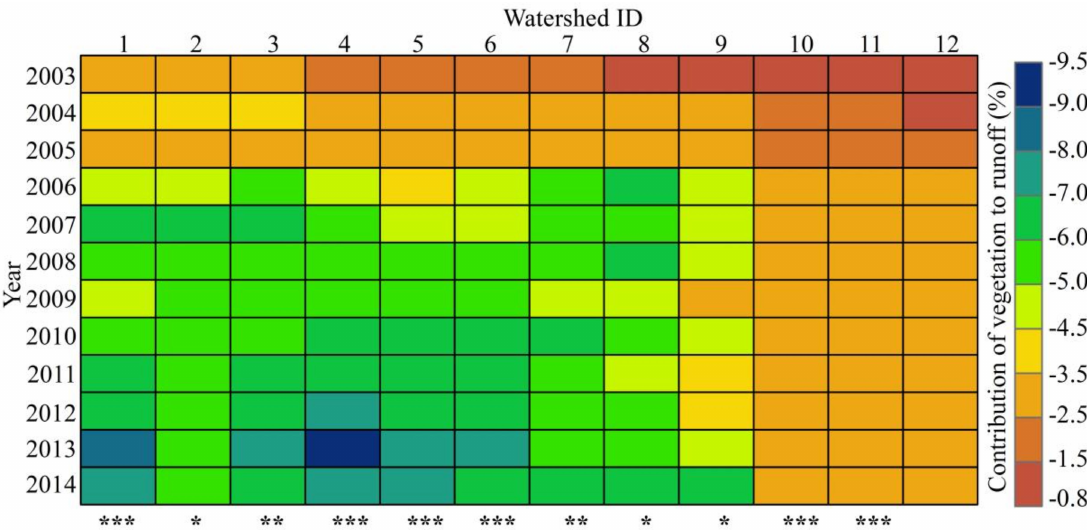
Figure 9. The relative contribution rate of regreening to runo ff ( RC_fPAR ) in the 12 watersheds for recent years during 2003–2014. Each year’s value refers to the adjacent five-year. *, **, and *** refer to the significance of the contribution rate trend at the level of p = 0.1, 0.01 and 0.001,